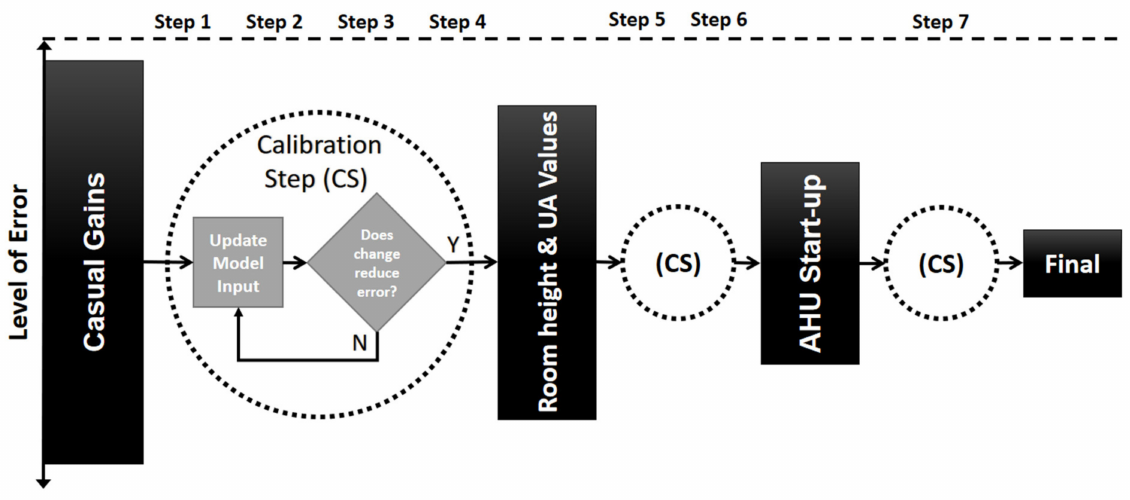
Figure 4. Overview of the systematic calibration process to improve the models